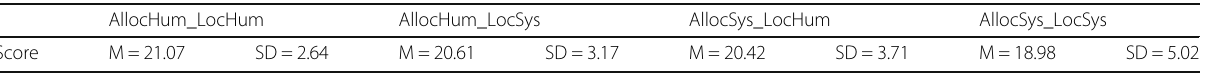
Table 3 No differences in spatial memory scores for the “ Building Memory ” test (by Ekstrom et al., 1976) across groups (means and standard